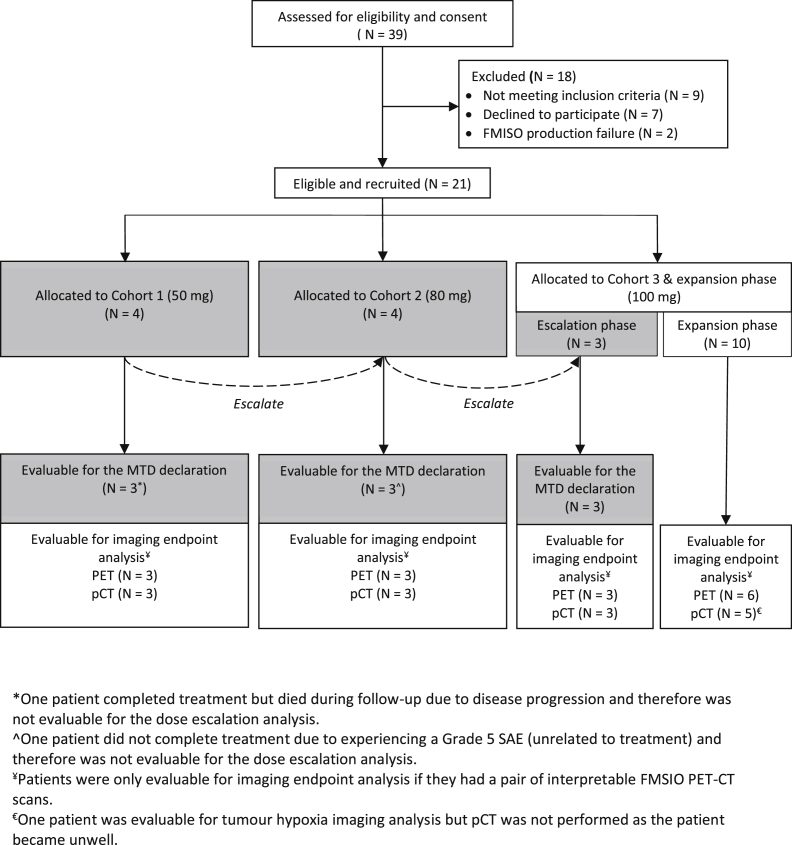
Consort diagram. FMISO, 18F-fluoromisonidazole; MTD, maximum tolerated dose; PET, positron-emission tomography; pCT, perfusion computed tomography.